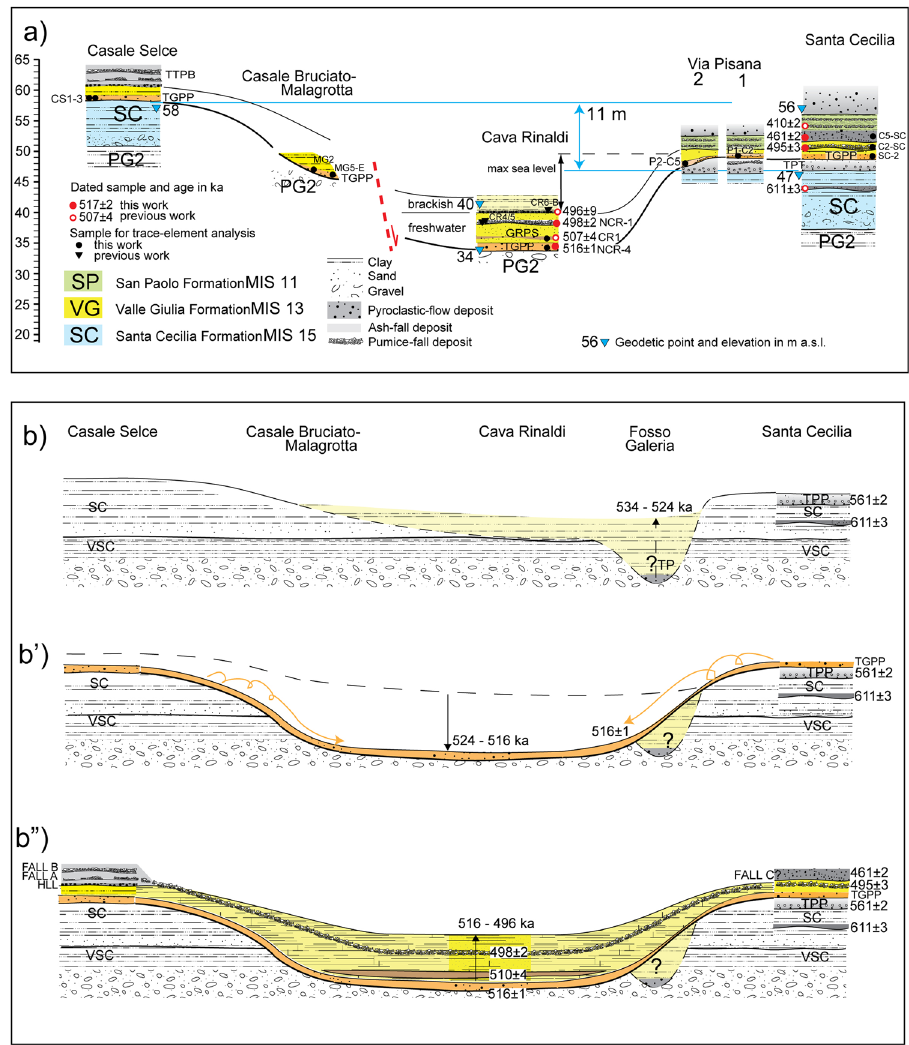
Figure 3. ( a ) Cross-section showing the stratigraphic relationships among the VGF and the previous (Santa Cecilia Formation -SC, MIS 15 (ref. 3)) and the following (San Paolo Formation -SP, MIS 11 (ref. 3)) aggradational succession at the investigated geologic sections in the western area of Rome (see Fig. 1 for location) b-b”) Reconstruction of the erosional/depositional phases during aggradation of the VGF showing the occurrence of an erosive phase coeval with emplacement of TGPP (b’), supposed to follow an early aggradational phase ( b ) corresponding to that evidenced in Rome to occur during emplacement of TP, and followed by deposition of the late aggradational succession of the VGF (b”) (see text for